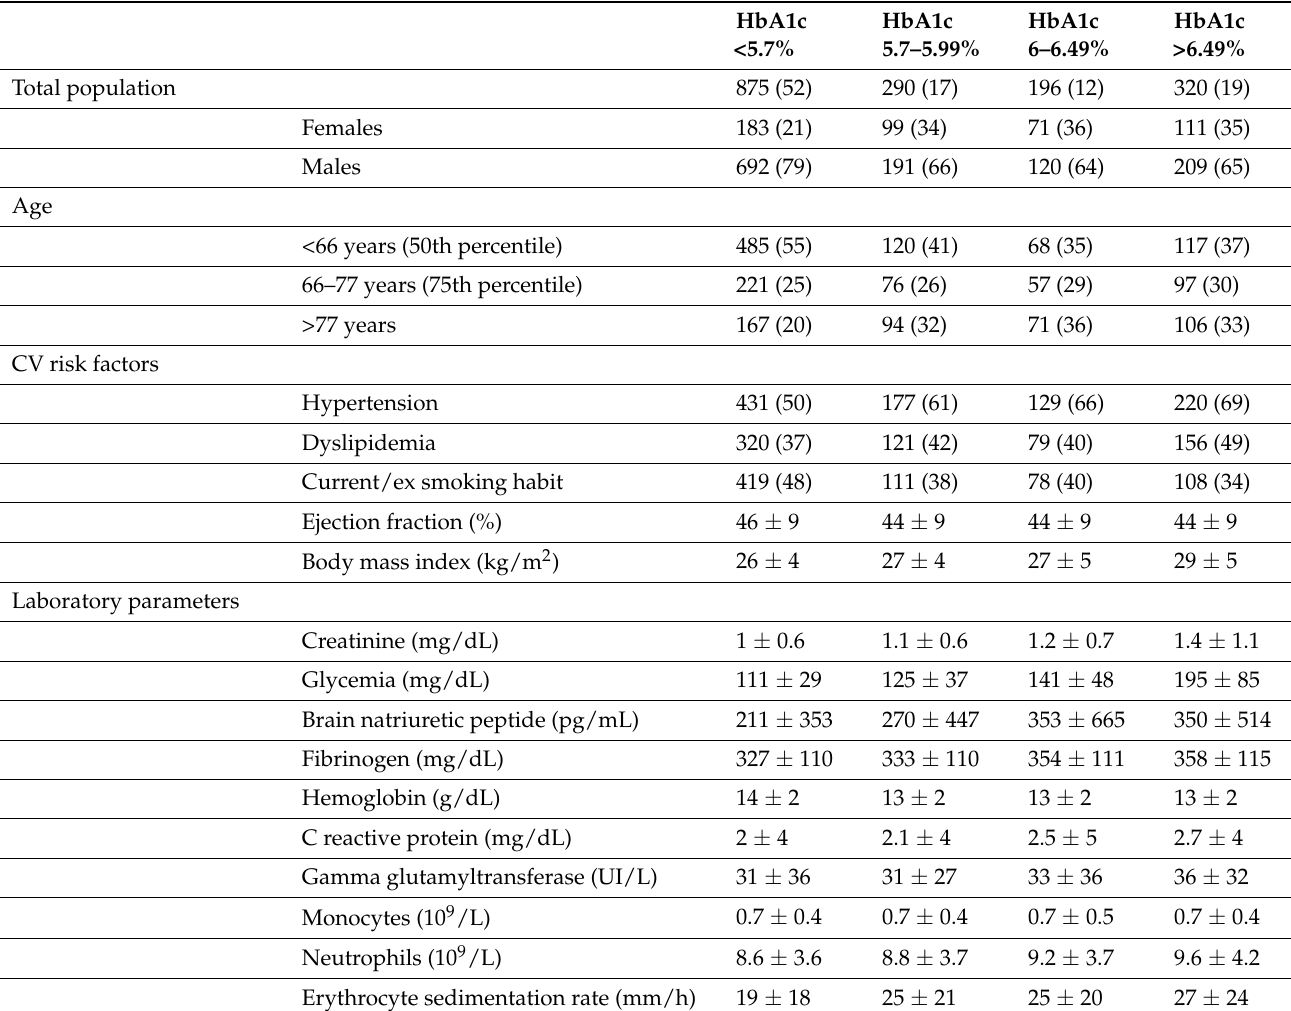
Table 1. Demographic, clinical, and laboratory parameters according to HbA1c intervals.